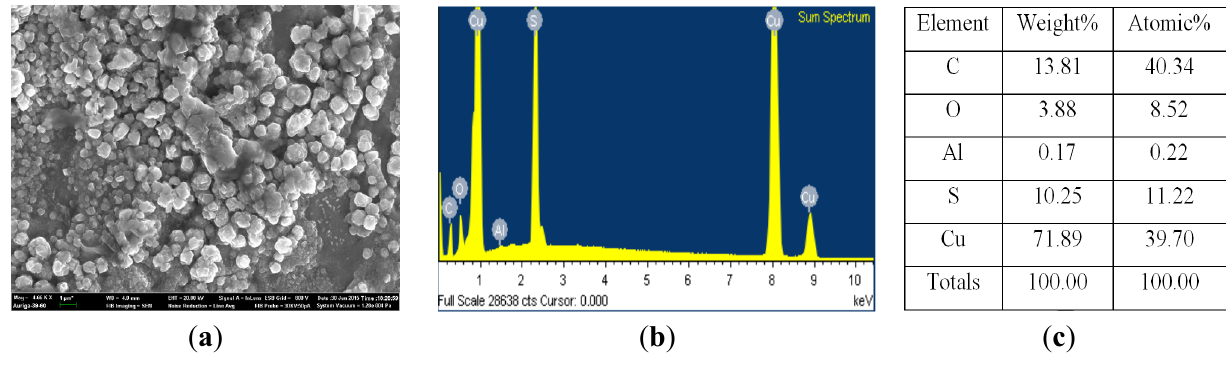
Figure 4. ( a ) SEM image; ( b ) energy dispersive X-ray (EDX) analysis; and ( c ) element composition of copper